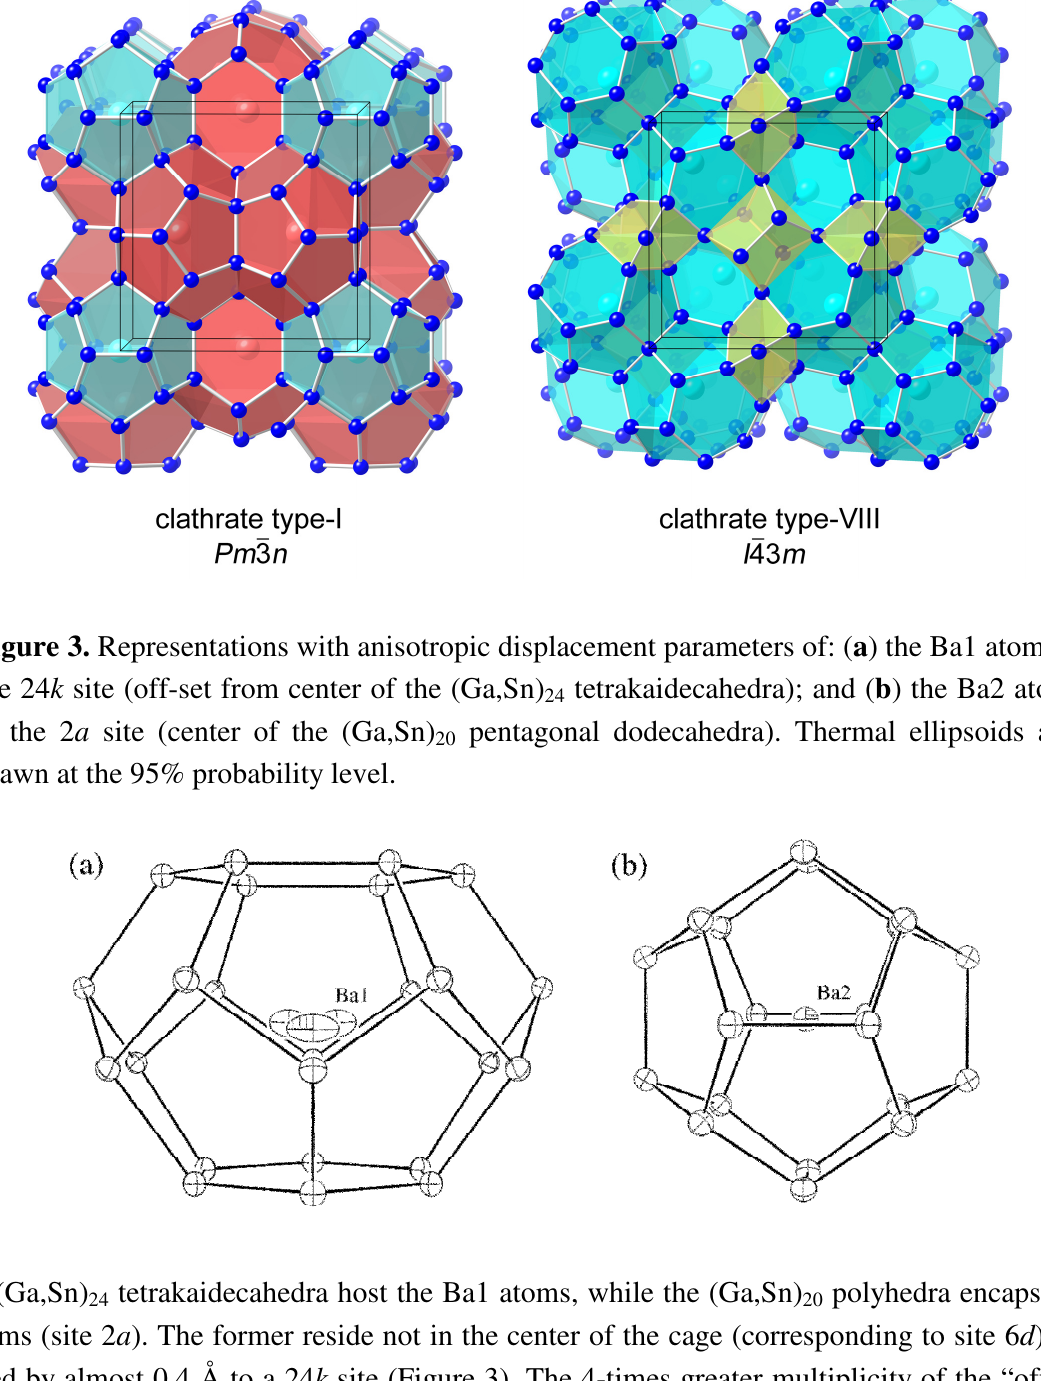
Ga Sn (type- 8 13.2 32.8(3)